Question: Express in one sentence what the figure is showing.
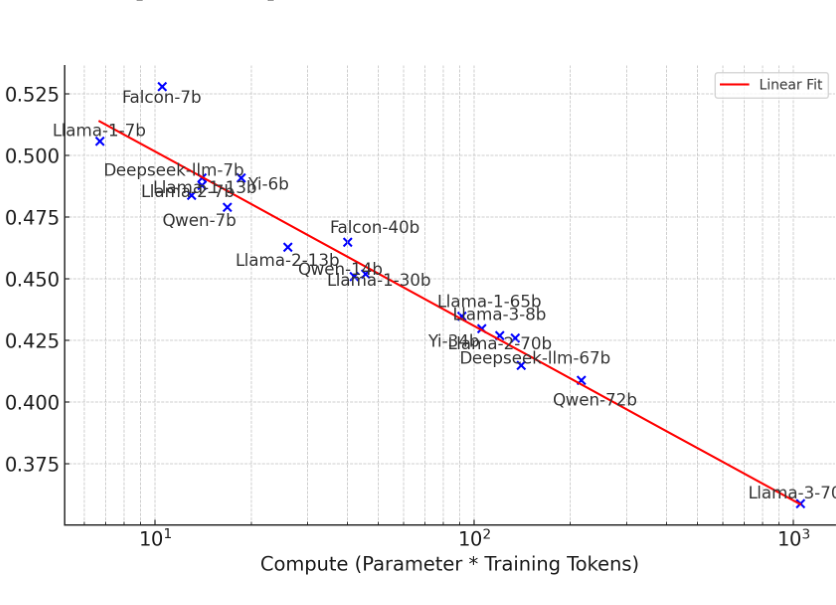
Answer: Model performance scales linearly with the log scale of compute.